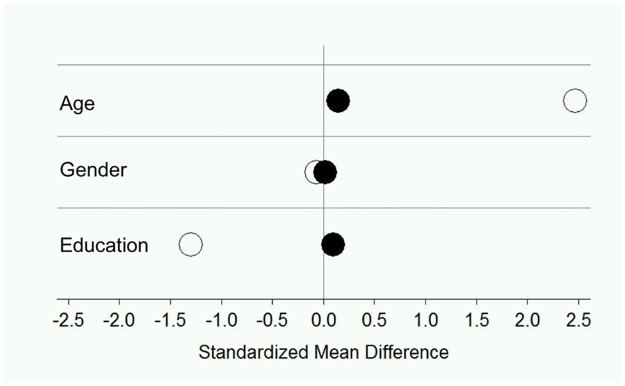
BASE and BASE-II before and after propensity score matching.Illustrating standardized mean differences between the Berlin Aging Study (BASE) and Berlin Aging Study-II (BASE-II) cohorts/samples in sociodemographic variables. Negative (positive) numbers signify greater scores for BASE (BASE-II) participants (unfilled circles). After the matching (black circles), the differences were small and not reliably different from 0 at p < 0.05.